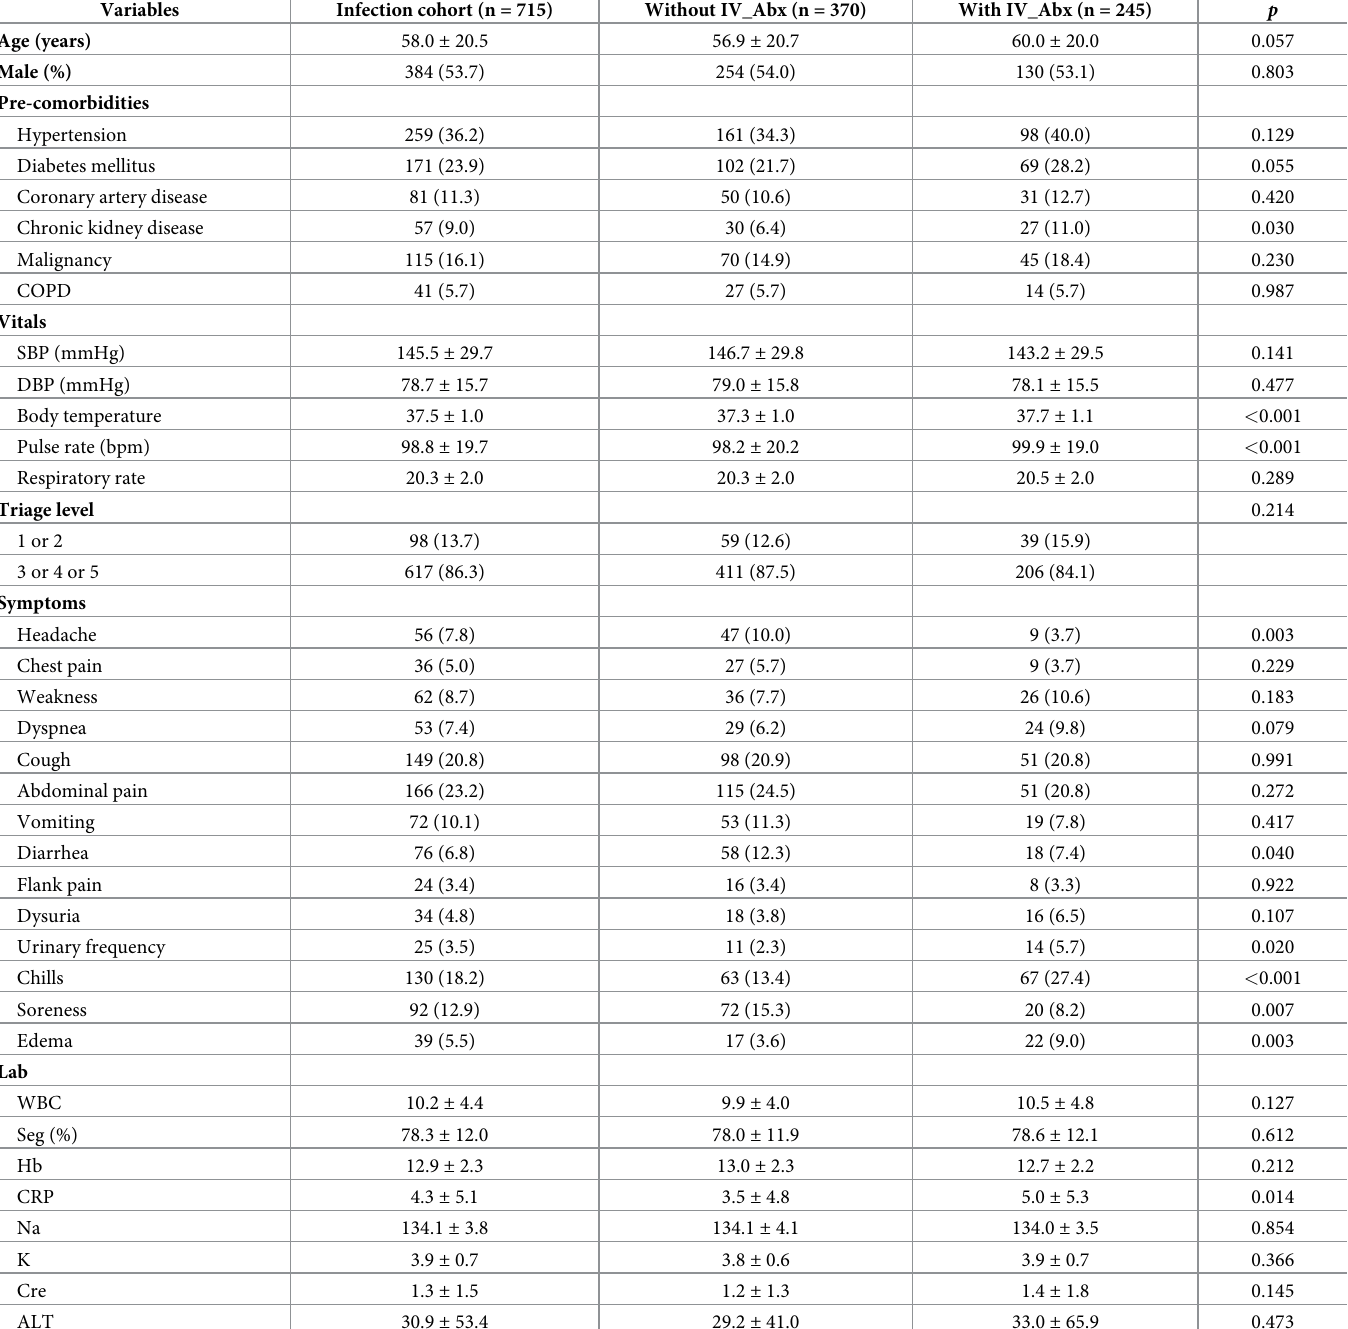
Table 1. Comparison of demographics, pre-comorbidities, vitals, symptoms, lab data at index visit in patients with a diagnosis of infectious cohort (infection